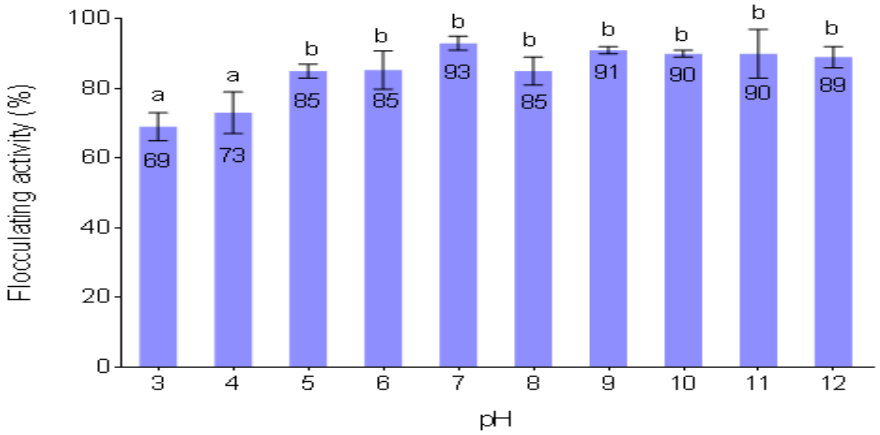
Figure 5. E ff ect of pH on the purified bioflocculant di ff erent letters (a & b) denotes statistical significance Figure 5. Effect of pH on the purified bioflocculant d ifferent letters (a & b) denotes statistical at ( p < significance at ( p < 0.05).